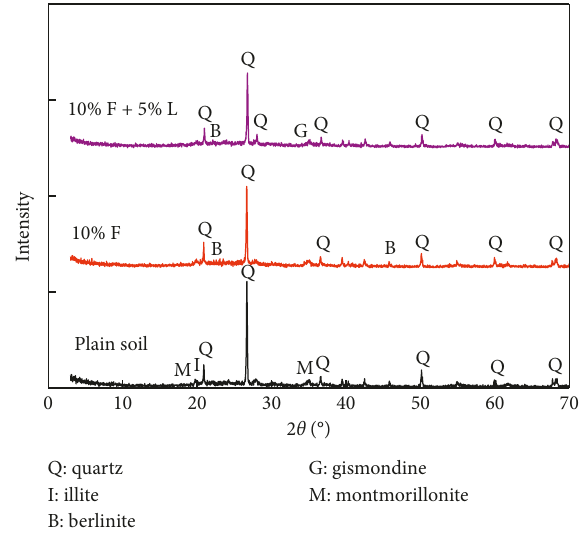
Figure 22: XRD pattern of expansive soil. Table 3: Comparison of mineral